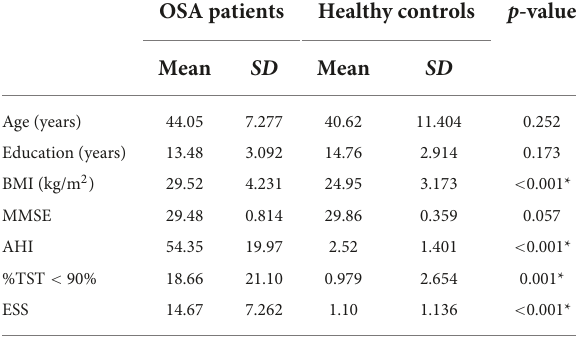
( Figure 1B ). The highest classification accuracy of